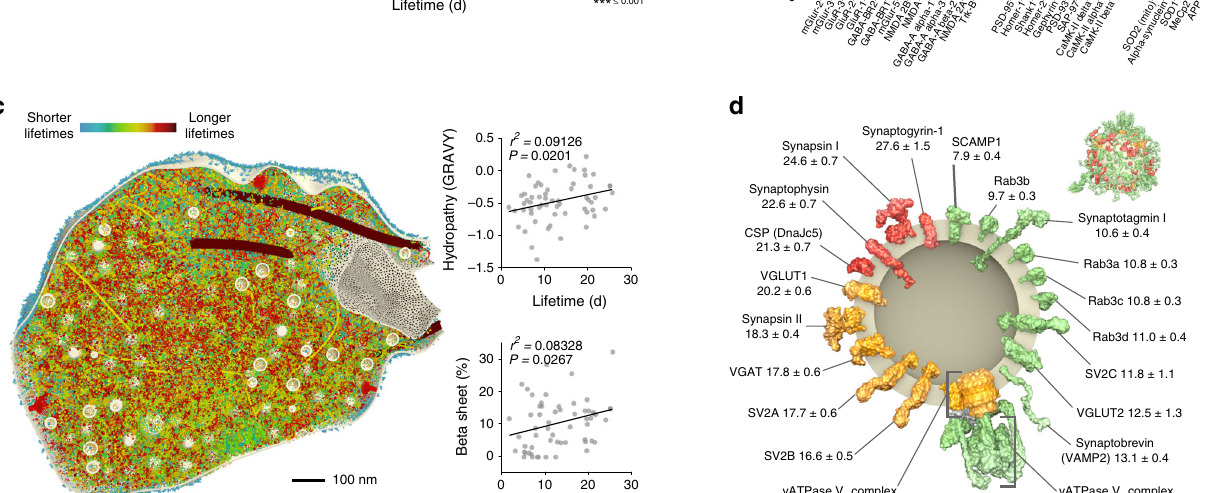
(11)Selected synaptic proteins (24)Presynaptic active zone (6)Synaptic vesicle proteins (10)Synaptic exocytosis cofactors (10)Postsynaptic active zone proteins Other postsynaptic proteins